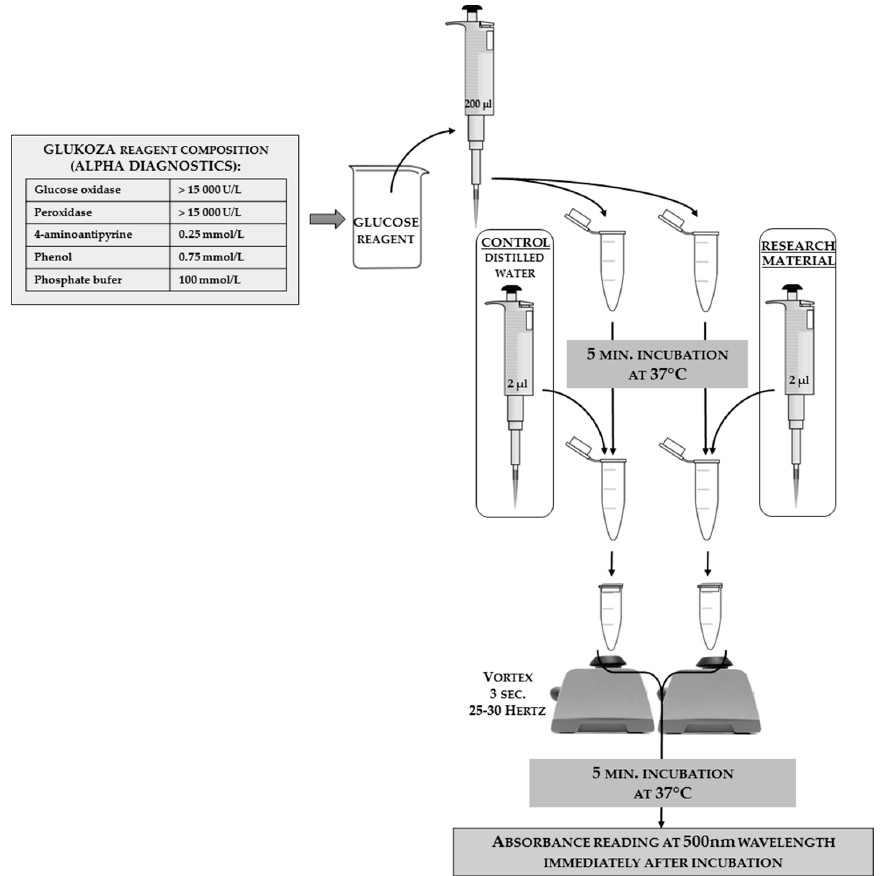
Figure 14. The scheme of glucose concentration analyses adjusted for insect hemolymph solutions with a one-reagent commercial kit from Alpha Diagnostics ® . The reagent composition declared